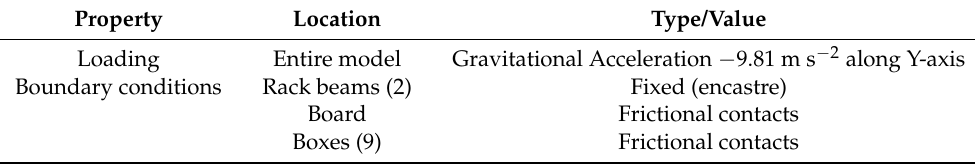
Table 2. Loading and boundary conditions used for the unit load segment